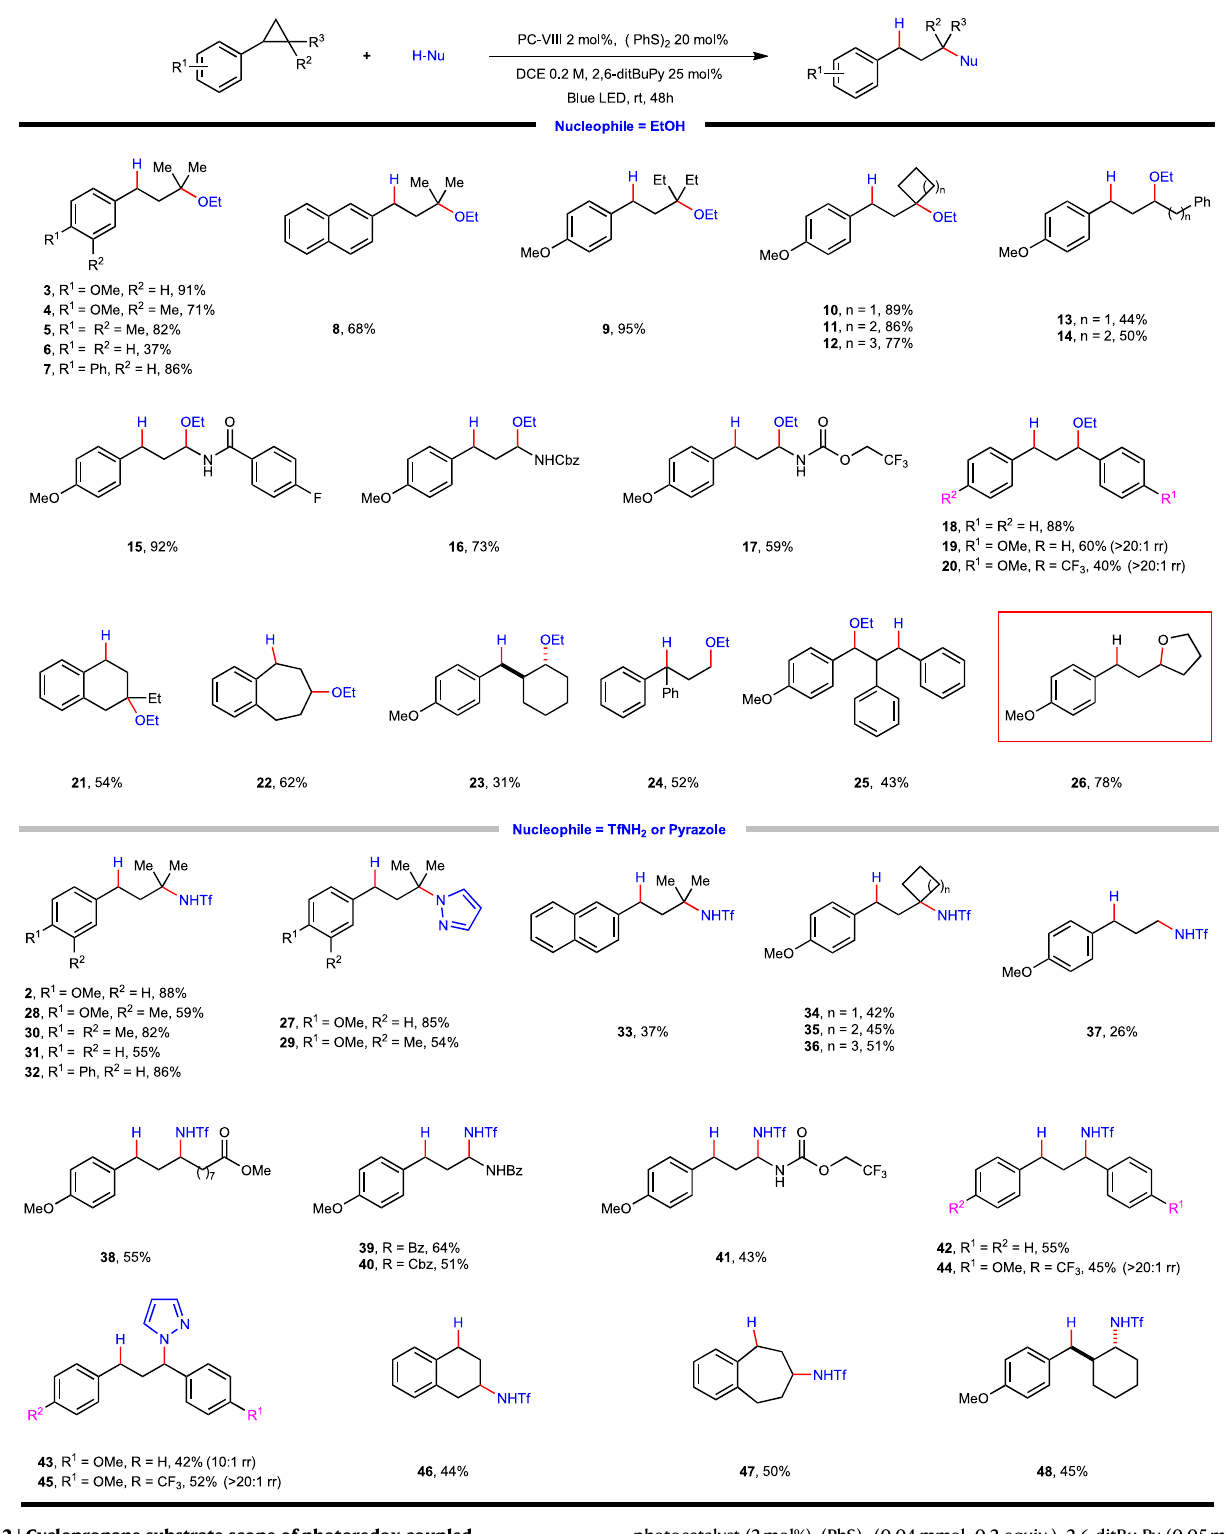
photocatalyst (2mol%), (PhS) 2 (0.04mmol, 0.2 equiv.), 2,6-ditBu-Py (0.05mmol, 0.25 equiv.) and DCE (1.0mL, 0.2M) at 25 o C for 48h under irradiation of a 15W blue LED